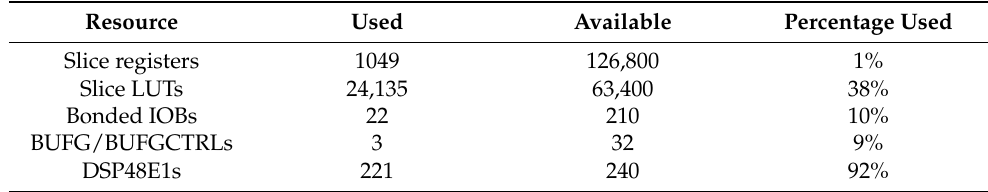
Table 2. Device utilization reports used by the Artix–7 FPGA. Resource Used Available Percentage Used Slice registers 1049 126,800 Slice LUTs Bonded IOBs BUFG/BUFGCTRLs